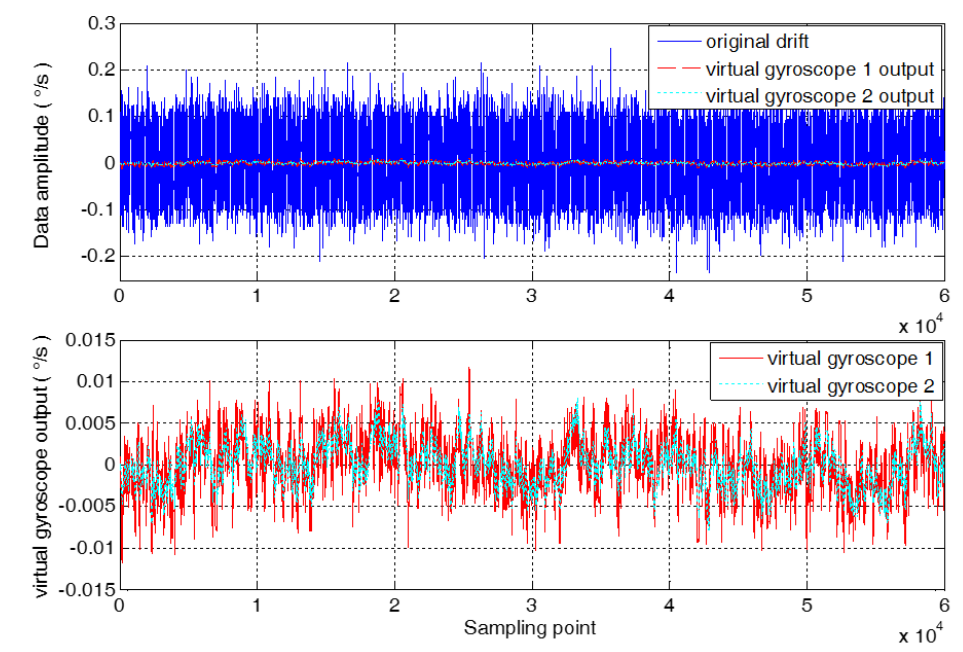
Figure 8. The comparison of the output of the virtual gyroscope.